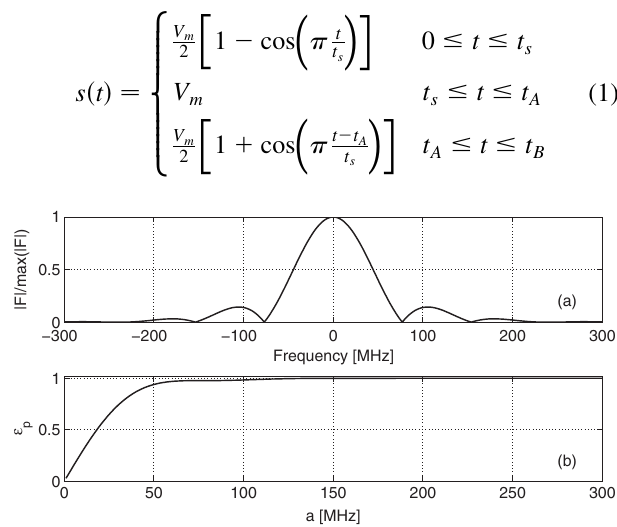
FIG. 2. (a) Normalized modulus of the pulse Fourier trans- term versus frequency. form; (b) (cid:3) p